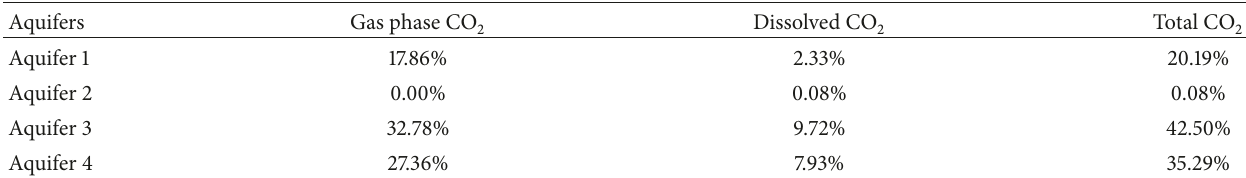
Table 6: CO 2 mass distribution in percentage among each aquifer at end of five years’